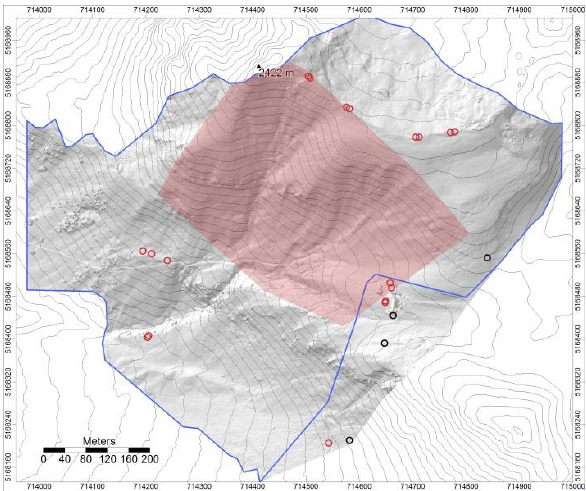
Figure 3. Test site overview and spatial coverage of the data sets. Shaded relief map: ULS data. Blue polygon: Coverage of ULS data used for change analysis. Light red: Convex hull of the TLS data. Red circles: Reference GNSS points used for georeferencing. Black circles: GNSS points excluded from georeferencing (points 18 -